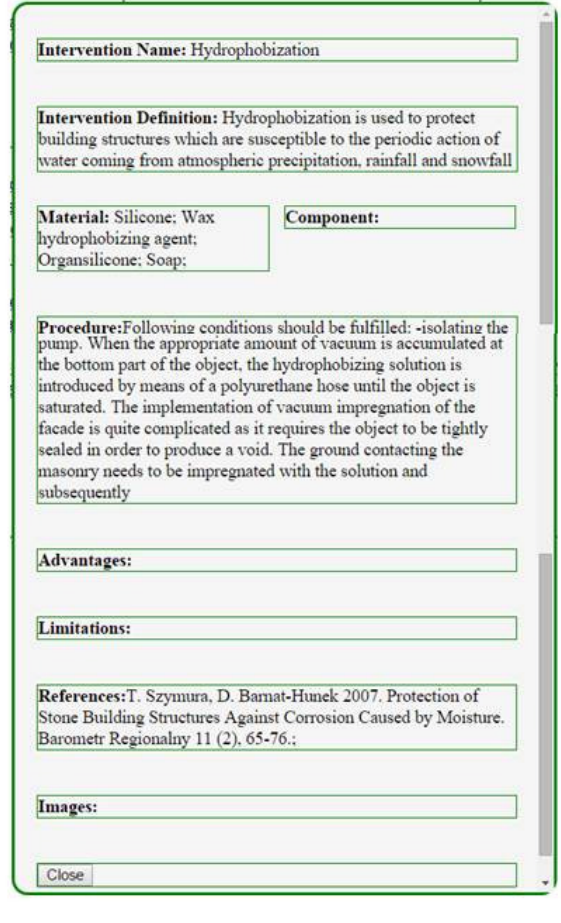
Figure 13. Intervention detail